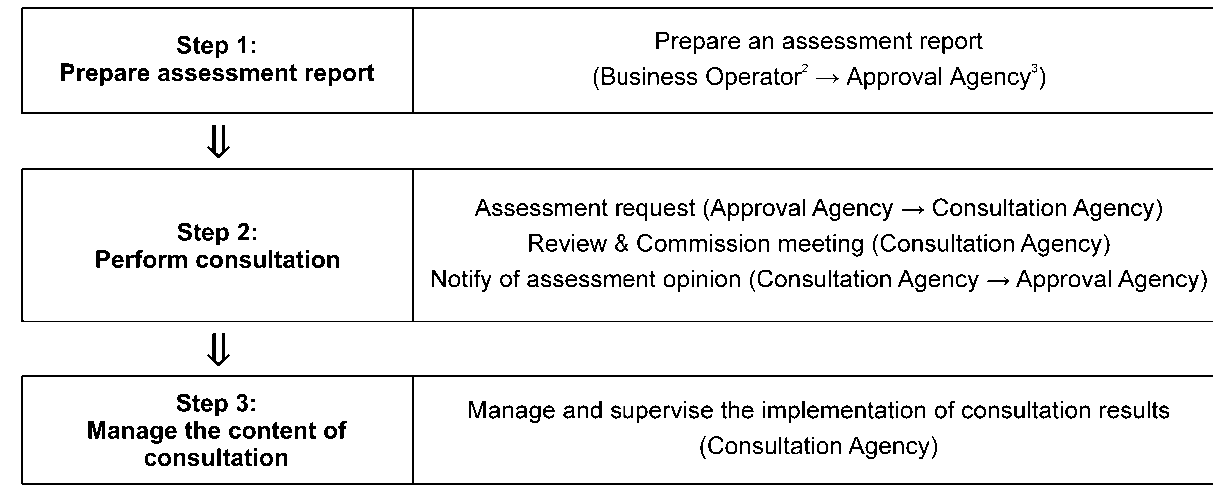
Figure 1. DIA operation procedure.